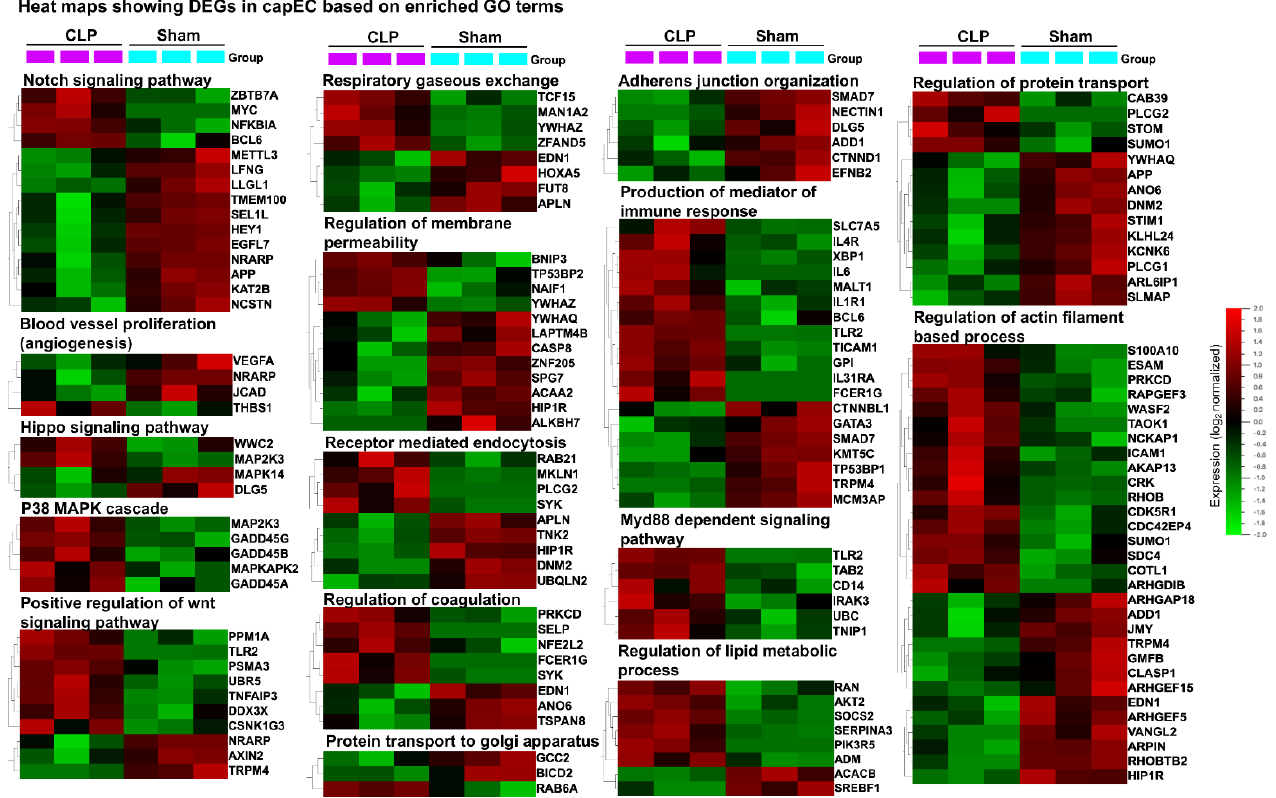
Figure 5. Heat maps showing DEGs ( p ≤ 0.05) with GO enriched term in capEC. Samples were collected 4 h after induction of abdominal sepsis. GO terms were based on biological process of Molecular Signatures Database (v7.2 MSigDB). For GSEA analysis, mouse genes were converted to human orthologs as described in the materials and methods section. Hierarchical clustering of variables and box color of heat maps were based on data normalization, mean = 0, variance = 1.